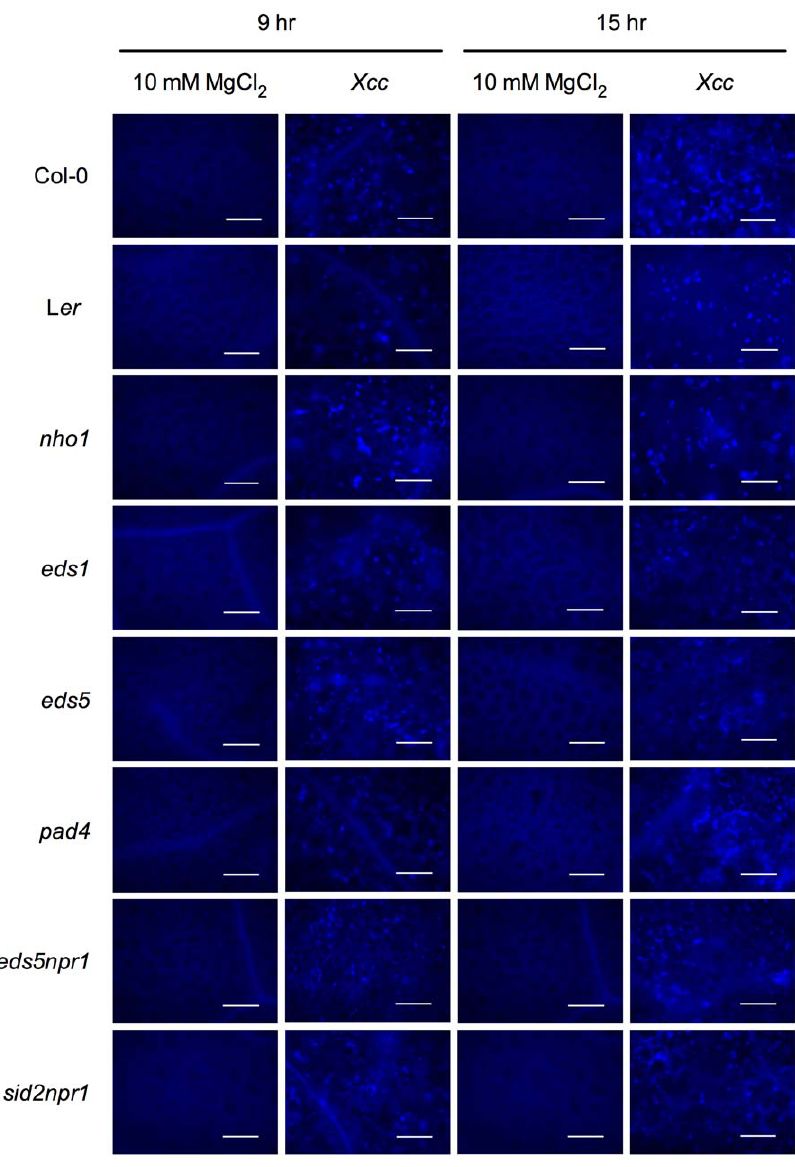
Figure 7. Xcc -induced callose deposition is not changed in the SA signaling mutants. Four-week-old Arabidopsis plants were inoculated with Xcc (OD 600 =0.2) or mock-treated with 10 mM MgCl 2 . At 9 and 15 hpi, inoculated leaves were excised and stained with aniline blue. Fluorescence was observed using an Olympus BH-2 epifluorescent microscope. No significant differences were detected among wild type (Col-0 and L er ) and the mutant plants. Representative images shown here came from 24 leaves from 12 independent plants. Bars represent 100 m